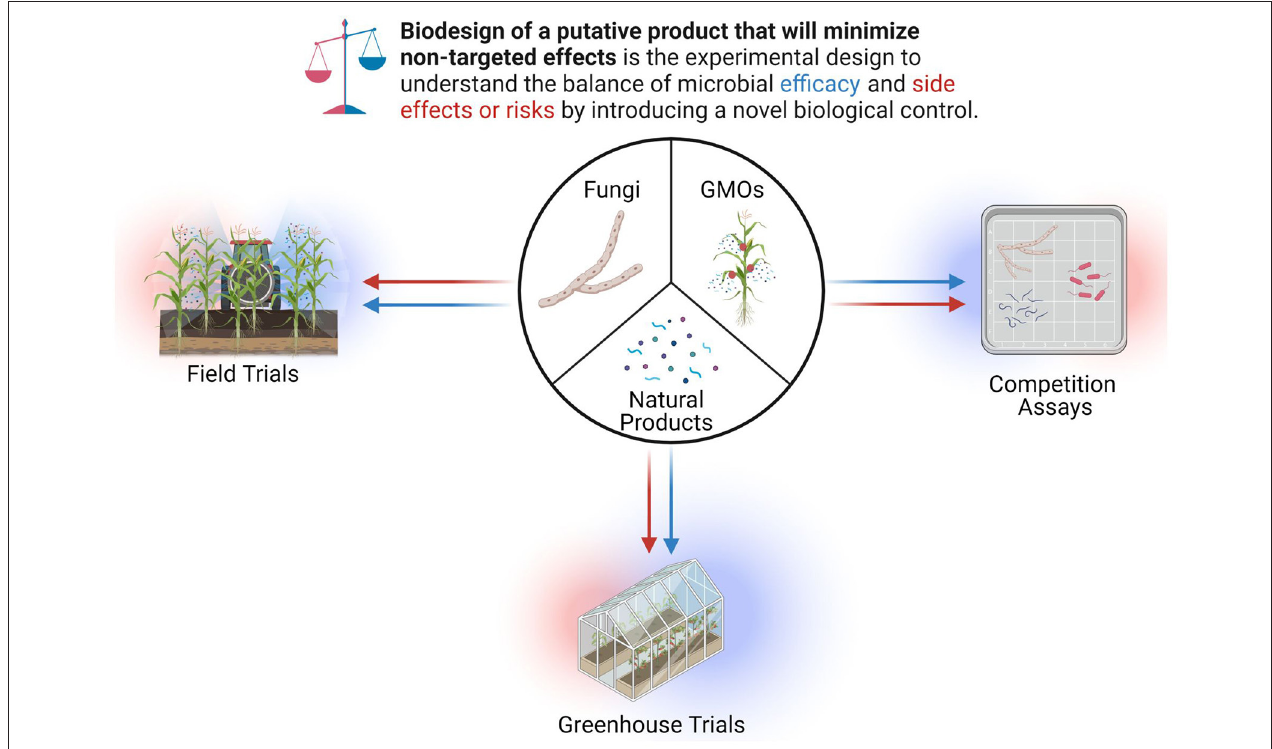
FIGURE 11 | Biodesign of putative products to minimize untargeted effects.